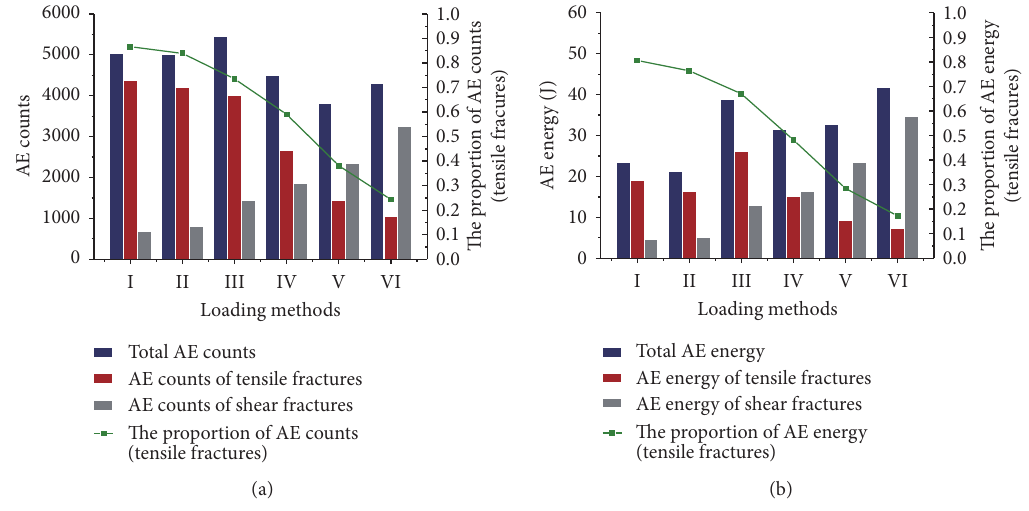
Figure 5: AE features under six different loading methods. (a) AE counts; (b) AE